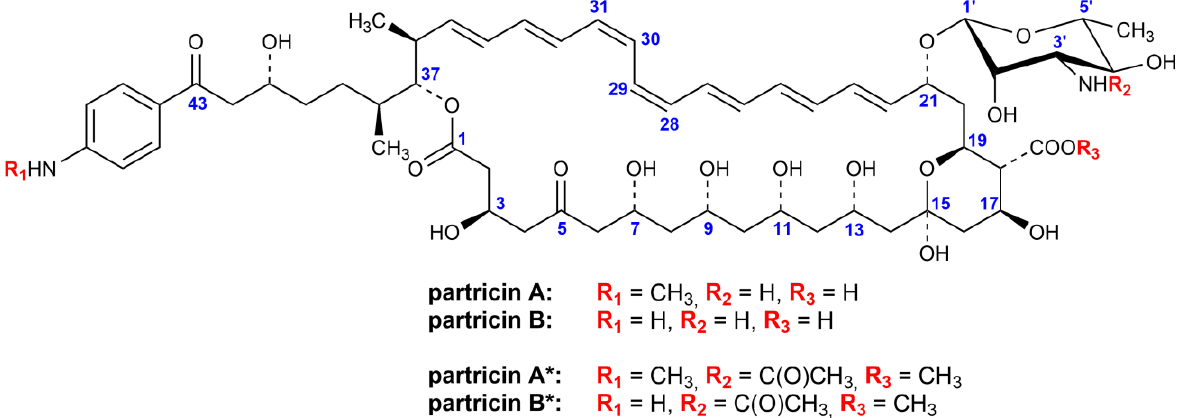
Figure 1. Structure of partricins A and B, along with their methyl esters of N-acetyl derivatives. Although partricin is not currently used as a weapon against systemic mycoses, methyl ester of partricin, aka mepartricin (Ipertrofan and Tricandil), was proven to be useful in treatment of benign prostatic hyperplasia and chronic nonbacterial prostatitis/pelvic pain syndrome [11–14]. Similar to all members of the heptaenic family, mepartricin effectively binds to steroids, and this feature is considered to be the foundation of the therapeutic effect [15].